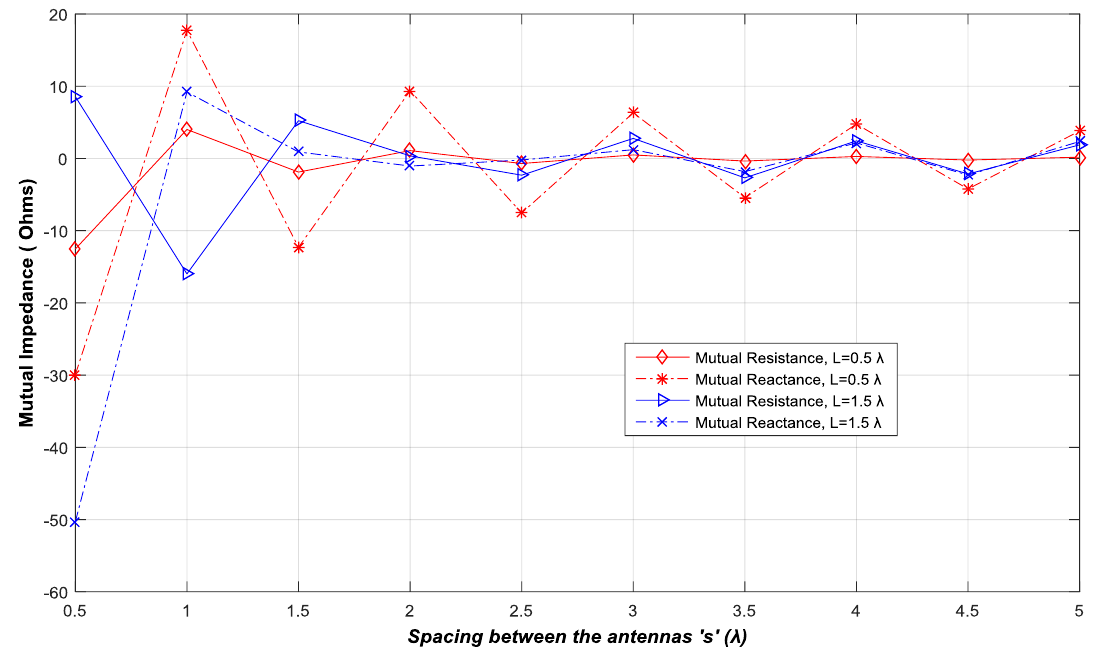
Figure 5. Mutual Impedances at different inter-antenna spacing.